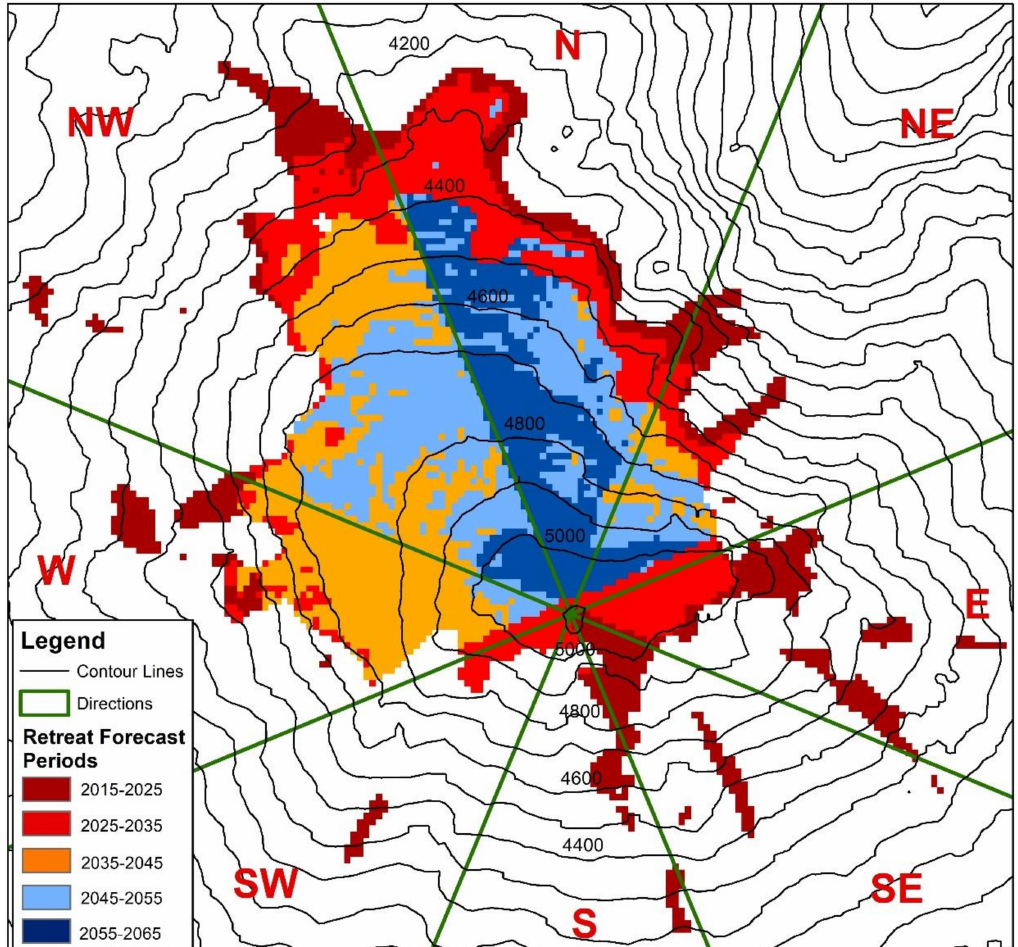
Figure 7. Future retreat scenarios for A˘grı